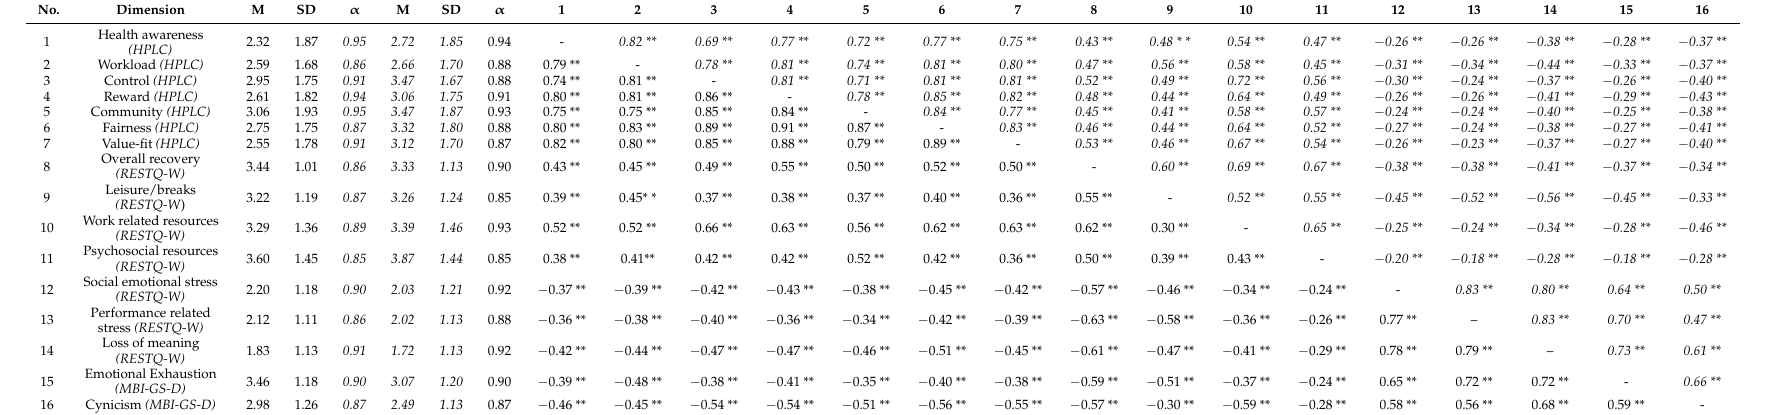
Table 1. Means, standard deviation, Cronbach’s Alpha ( α ) and correlations between all study variables (sample 1 and sample